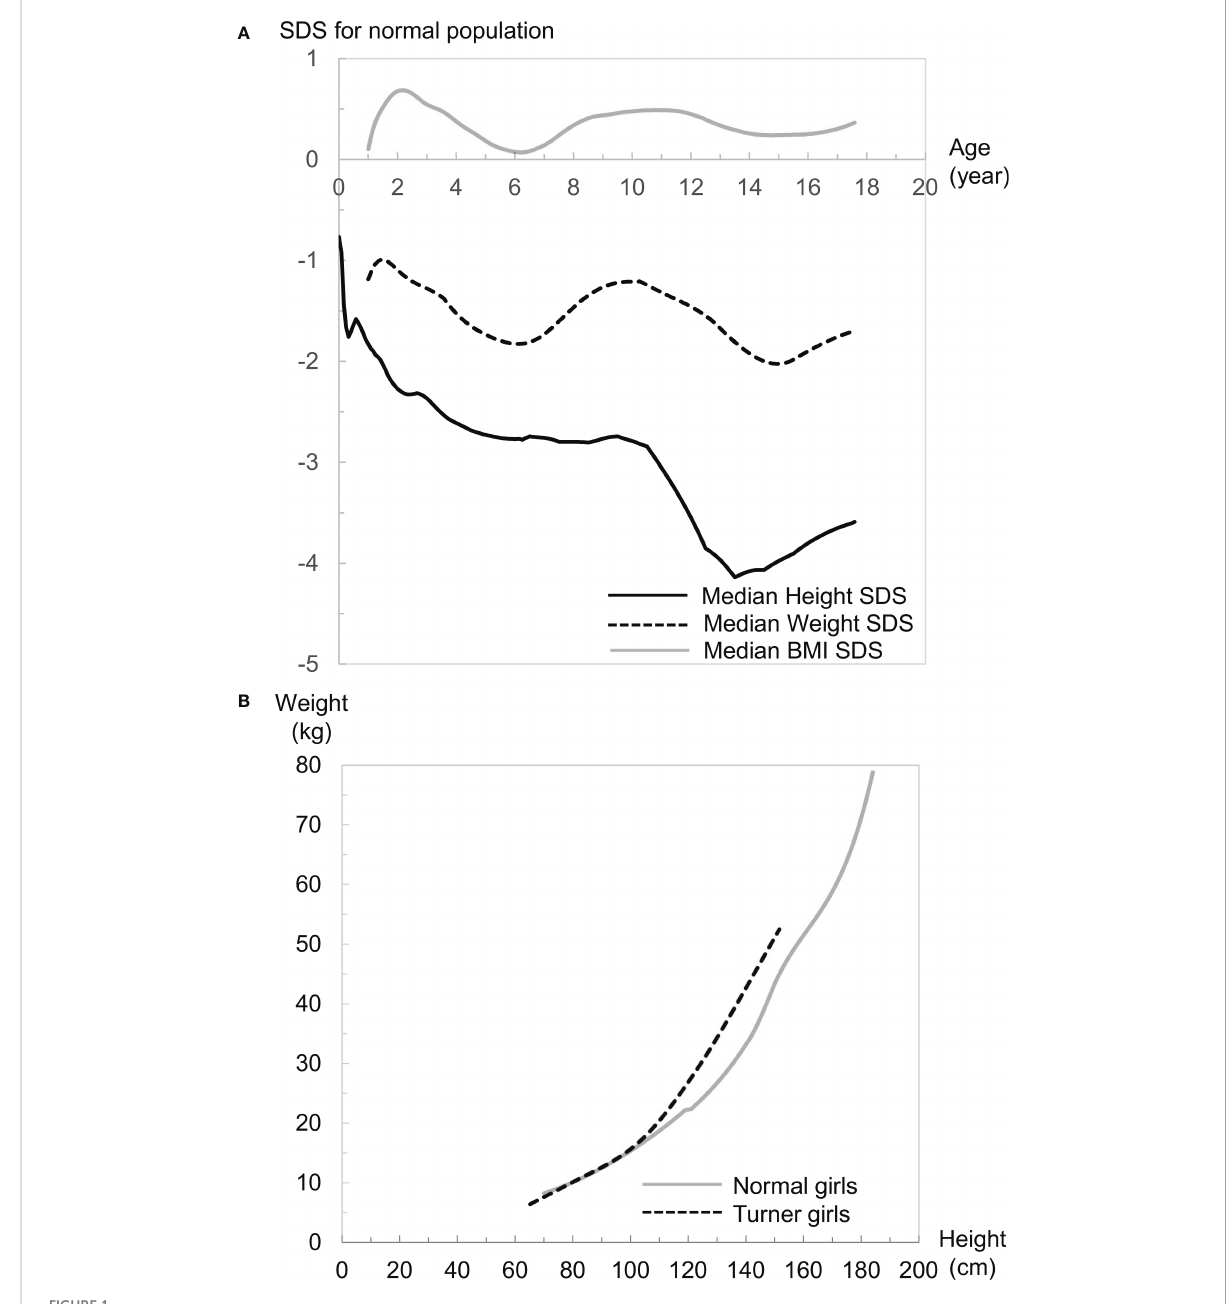
FIGURE 1 (A) Median height (black line), weight (black dotted line), and body mass index (BMI: gray line) standard deviation scores (SDS) of girls with Turner syndrome (TS) in the normal population. (B) Comparisons of weight for height (WFH) median lines between girls with TS (black dotted line) and girls of the normal population (gray